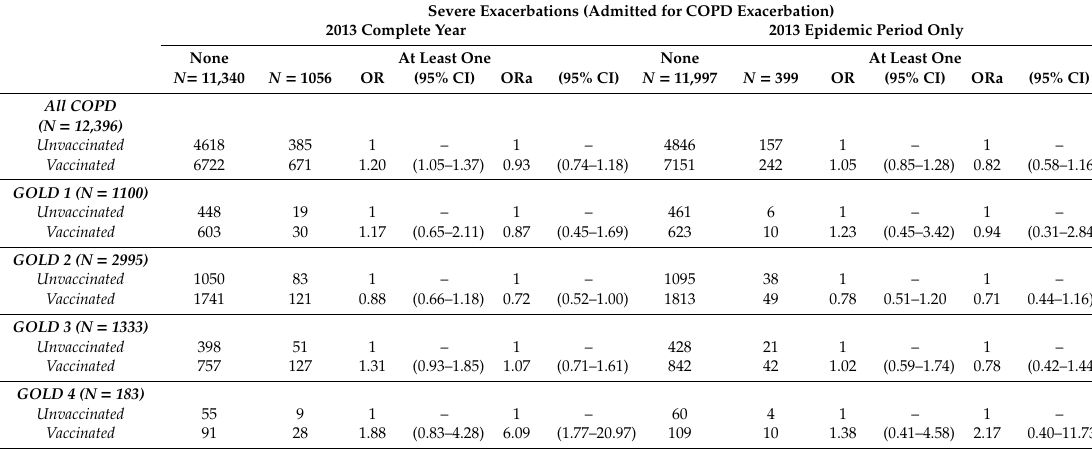
Table 3. Crude and adjusted associations between “History of Influenza Vaccination during 2012–2013 campaign” and risk of “Admission due to COPD Exacerbation” in all patients with a diagnosis of COPD by obstruction severity during the complete year and the epidemic